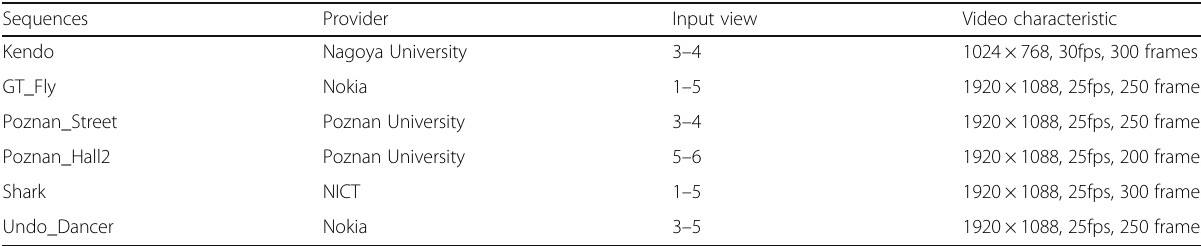
Table 11 Detailed information of test